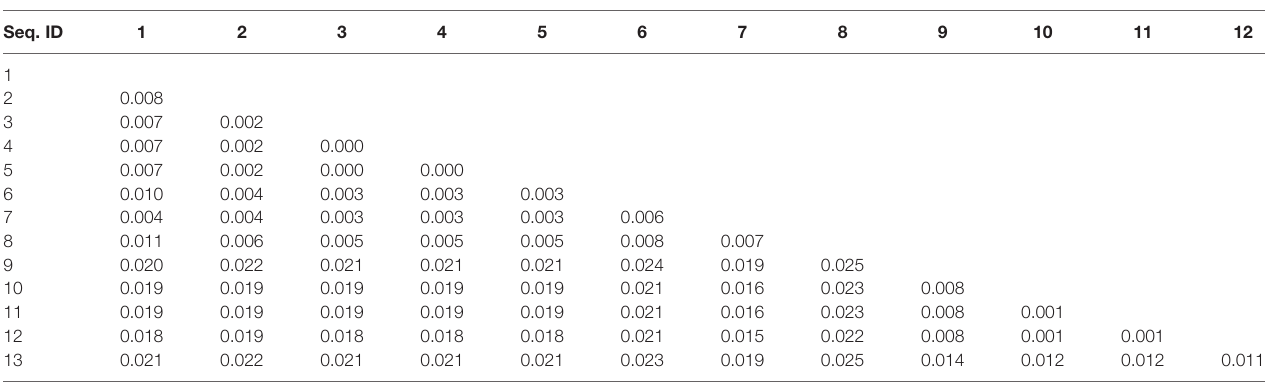
TABLE 3 | Genetic distances between sequences of the 18S rDNA V1-V9 region of Kareniaceae species. Seq. ID